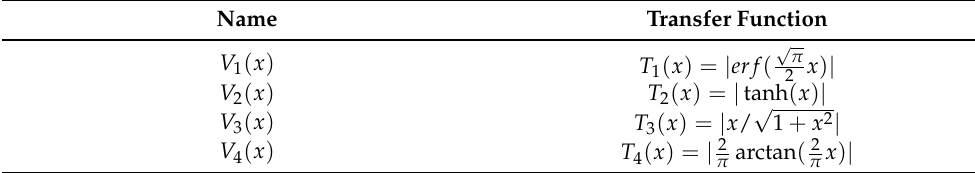
Table 3. The expressions of the V-shaped families of transfer functions.